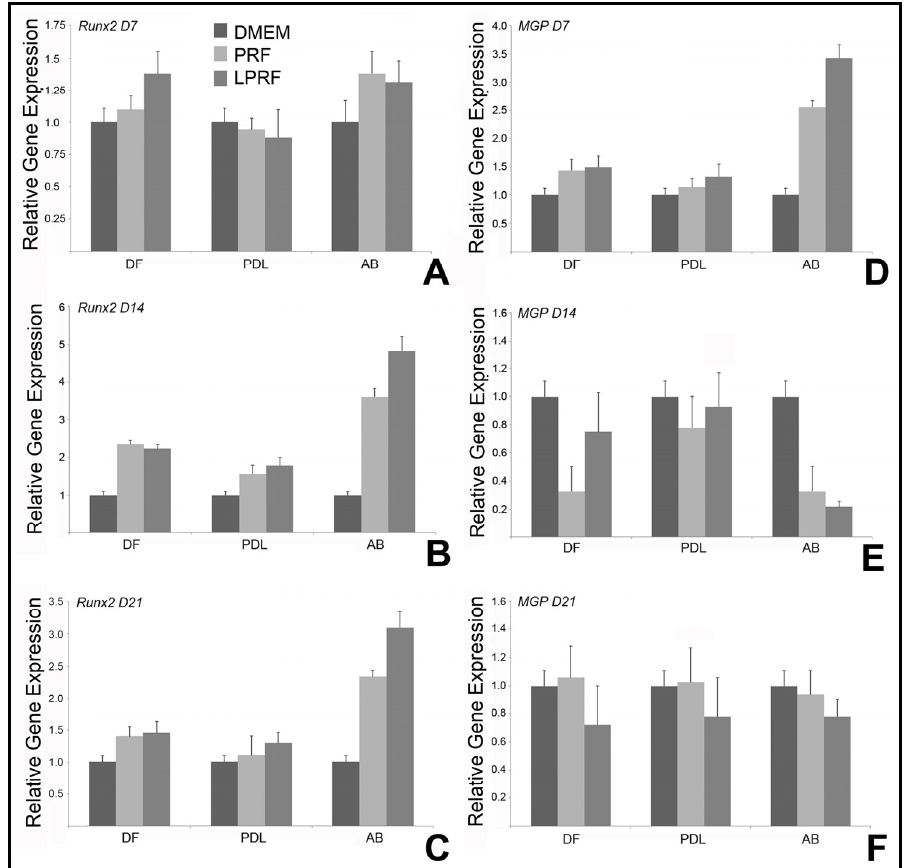
Figure 4. Differences in mineralization-associated gene expression patterns in co-cultures of periodontal progenitors and centrifuged blood derivatives. ( A – C ) are real-time RT-PCR assays for the osteoblast transcription factor Runx2; and ( D – F ) are real-time RT-PCR assays for the calcification inhibitor Matrix Gla Protein. Different co-culture conditions (fresh or lyophilized PRF and DMEM) are distinguished by different bar patterns identified in the upper right corner of the figure. The three periodontal progenitor populations compared in this study, dental follicle, periodontal ligament, and alveolar bone are labeled on the x -axis of the graphs in ( A – F